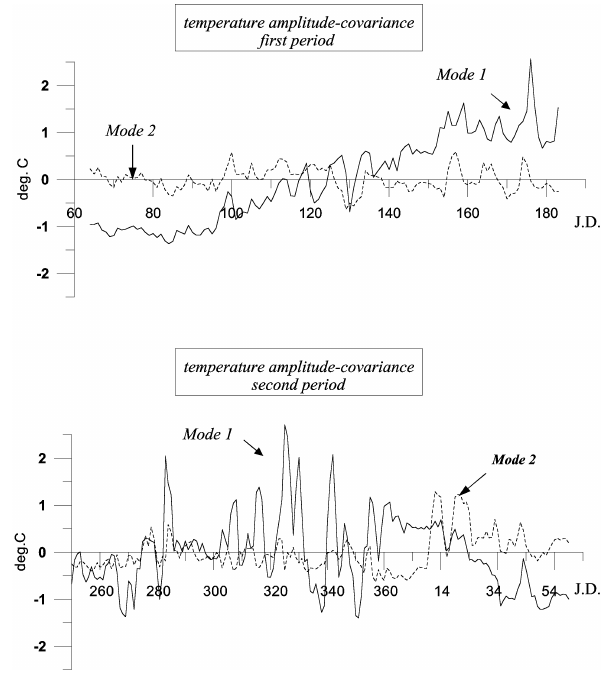
Fig. 13. Temperature amplitude time series for the whole period of measurements (04 March 2000 – 01 March 2001; J.D. 64 – J.D.